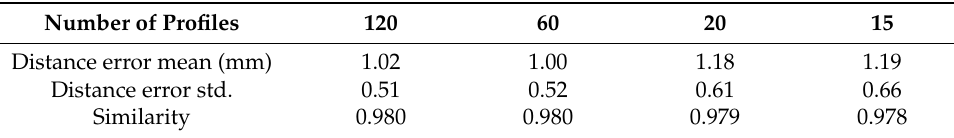
Table 2. Error evaluation for surface estimates of Model